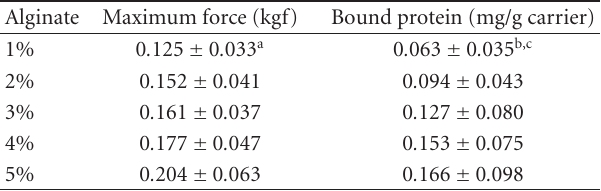
Table 2: Maximum force required to rupture beads and the amount of bound